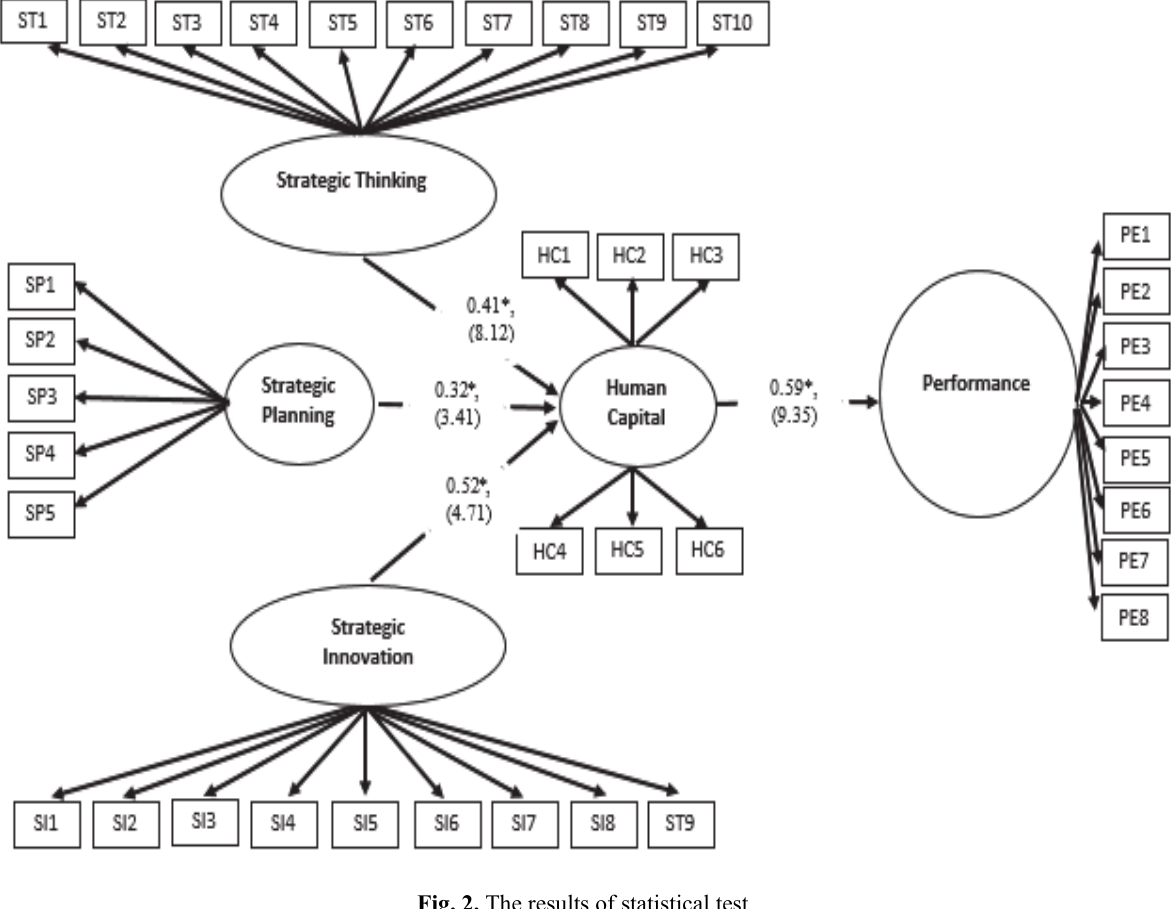
Fig. 2. The results of statistical